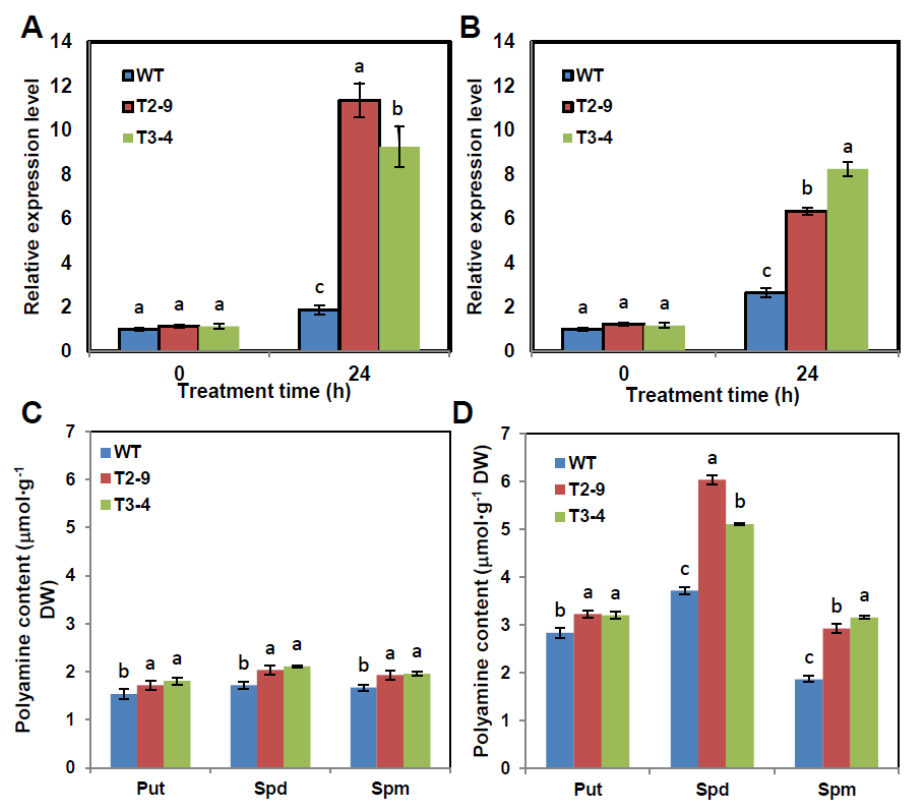
Figure 6. The genes expression analysis of ADC and free polyamine levels in transgenic plants. Expression profiles of AtADC1 ( A ) and AtADC2 ( B ) in WT and transgenic lines exposed to cold stress. Free polyamine levels in WT and transgenic lines before ( C ) and after ( D ) cold stress. Di ff erent letters present significant di ff erence ( p < 0.05). WT, wild type; Put, putrescine; Spm, spermine; Spd, spermidine.